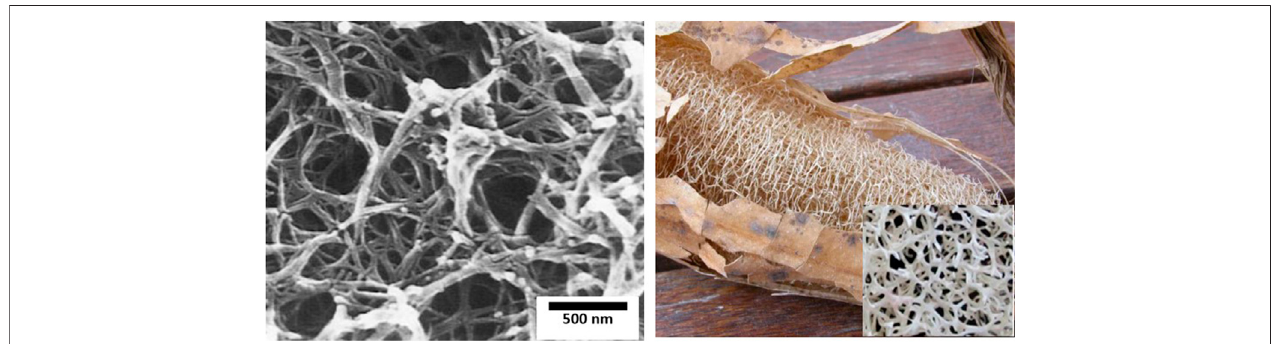
FIGURE 3 | Example of nanostructured ceramic material obtained in bicontinuous microemulsion. SEM of microskeletal calcium phosphate obtained in DDAB bicontinuous microemulsions (Reprinted with permission from Chem. Mater. 8 (1996) 1944 – 1953. Copyright (1996) American Chemical Society) compared with the fi brous structure of the Luffa (Copyright: Martin Stellar/EyeEm. Available on: https://www.gettyimages.fr/detail/photo/high-angle-view-of-dried-loofah-on-table-image- libre-de-droits/649132081.Theinsetinthe fi guredepictsthemicrostructureoftheluffa fi bers(Reprintedfrom Materials 10,5(2017)479.MDPI,Basel,Switzerland under the terms and conditions of the Creative Commons Attribution (CC BY) license).